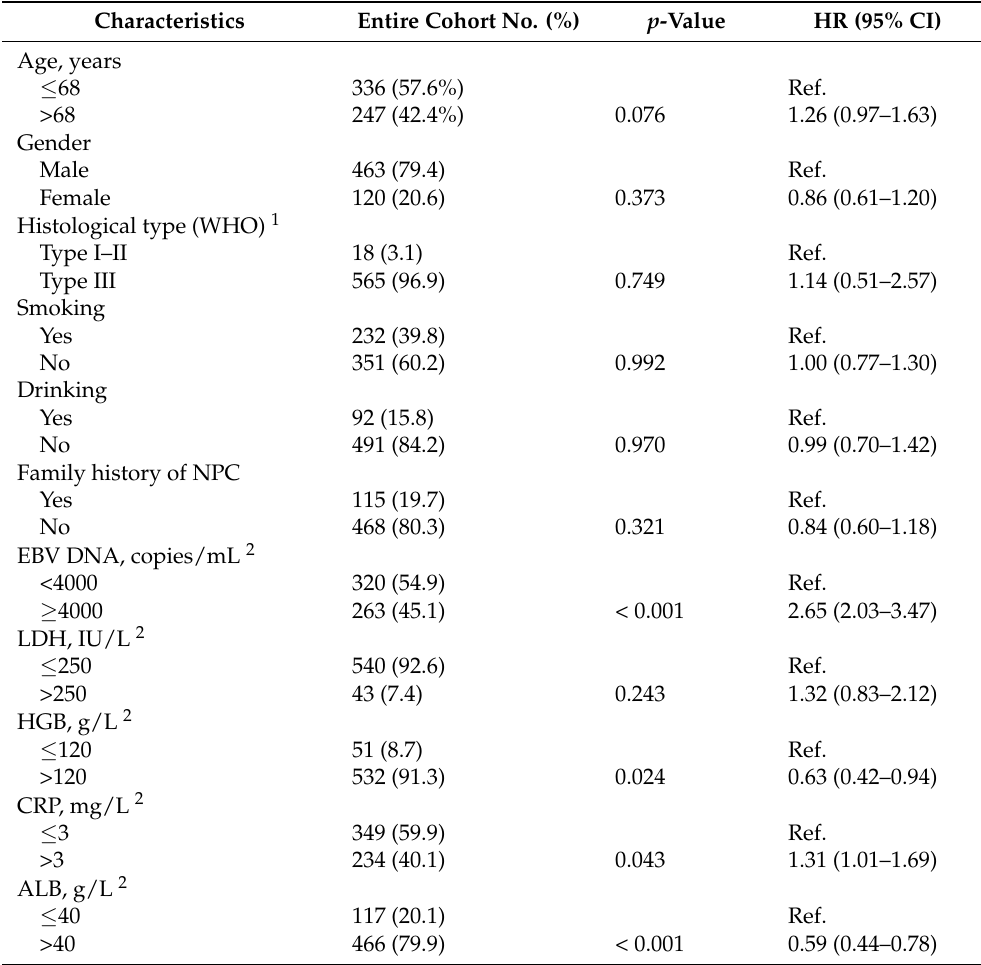
Table 1. Clinicopathologic characteristics and univariate analysis for DFS in the 583 elderly patients with locoregionally advanced nasopharyngeal